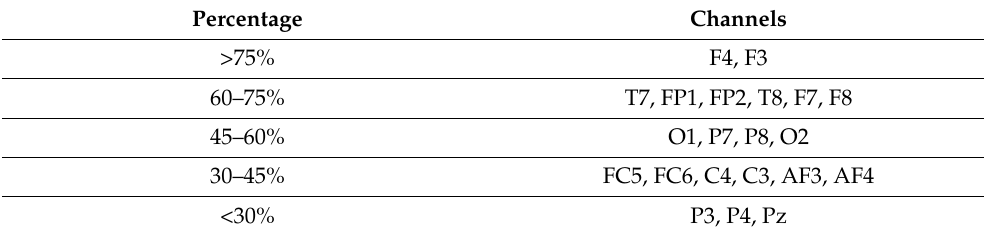
Table 2. The percentages of use of each EEG channel.